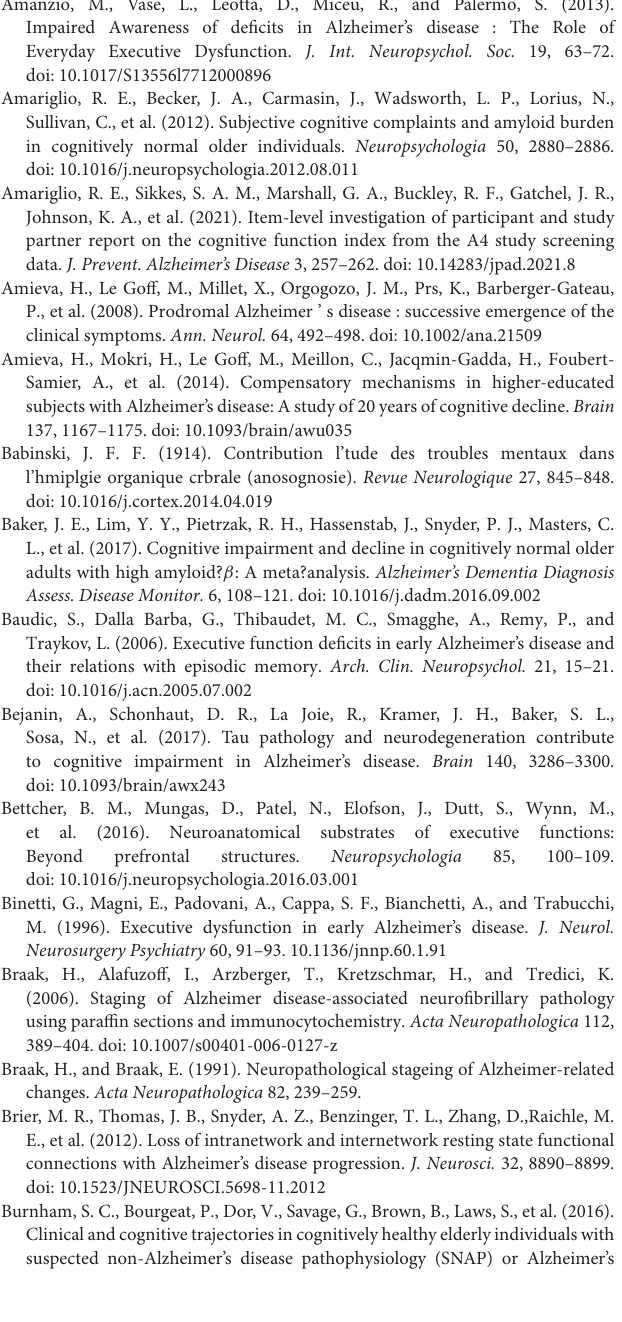
Supplementary Figure 1 | Relationship between executive function measure and awareness. Supplementary Figure 2 | Relationship between episodic memory measure and awareness. Supplementary Figure 3 | Relationship between amyloid measure and